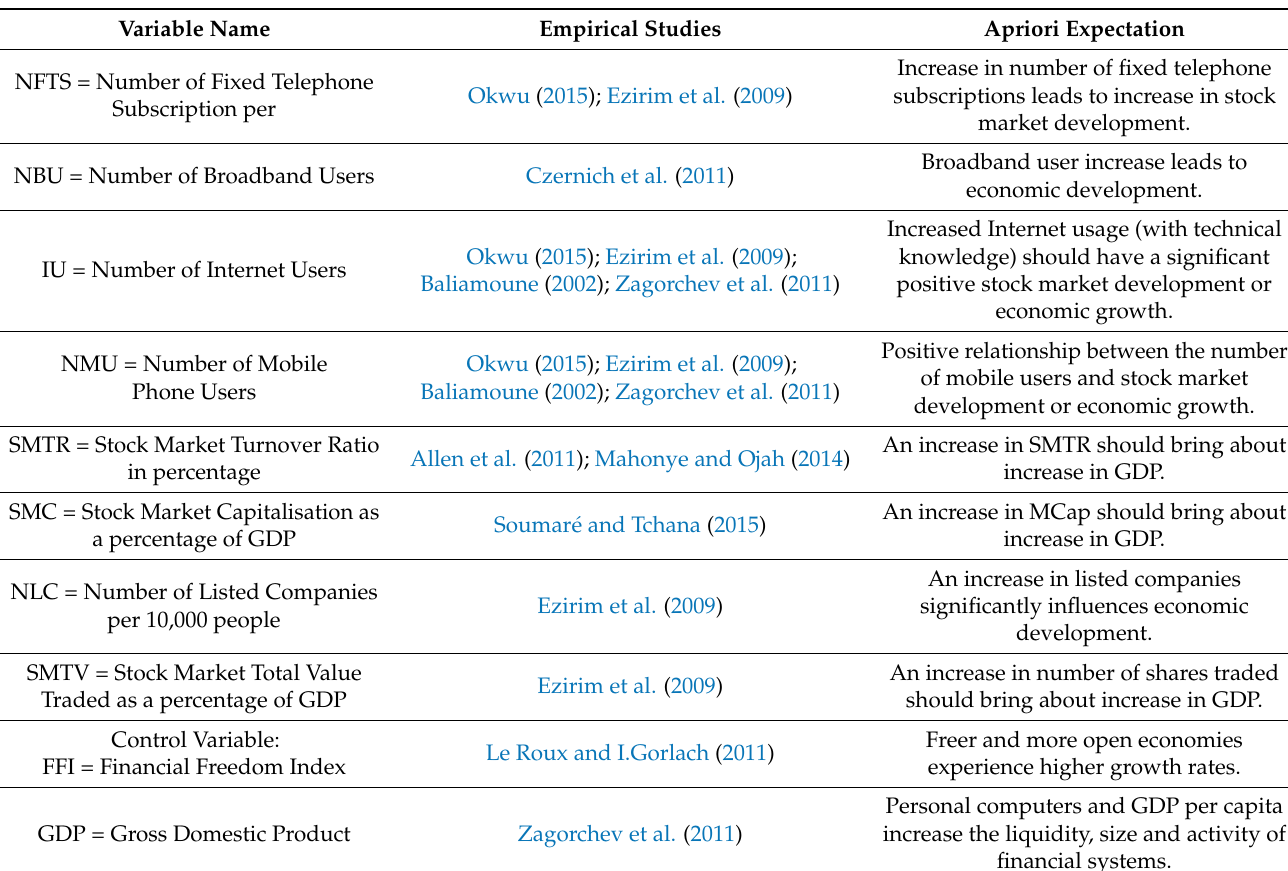
Table 1. Overview of empirical